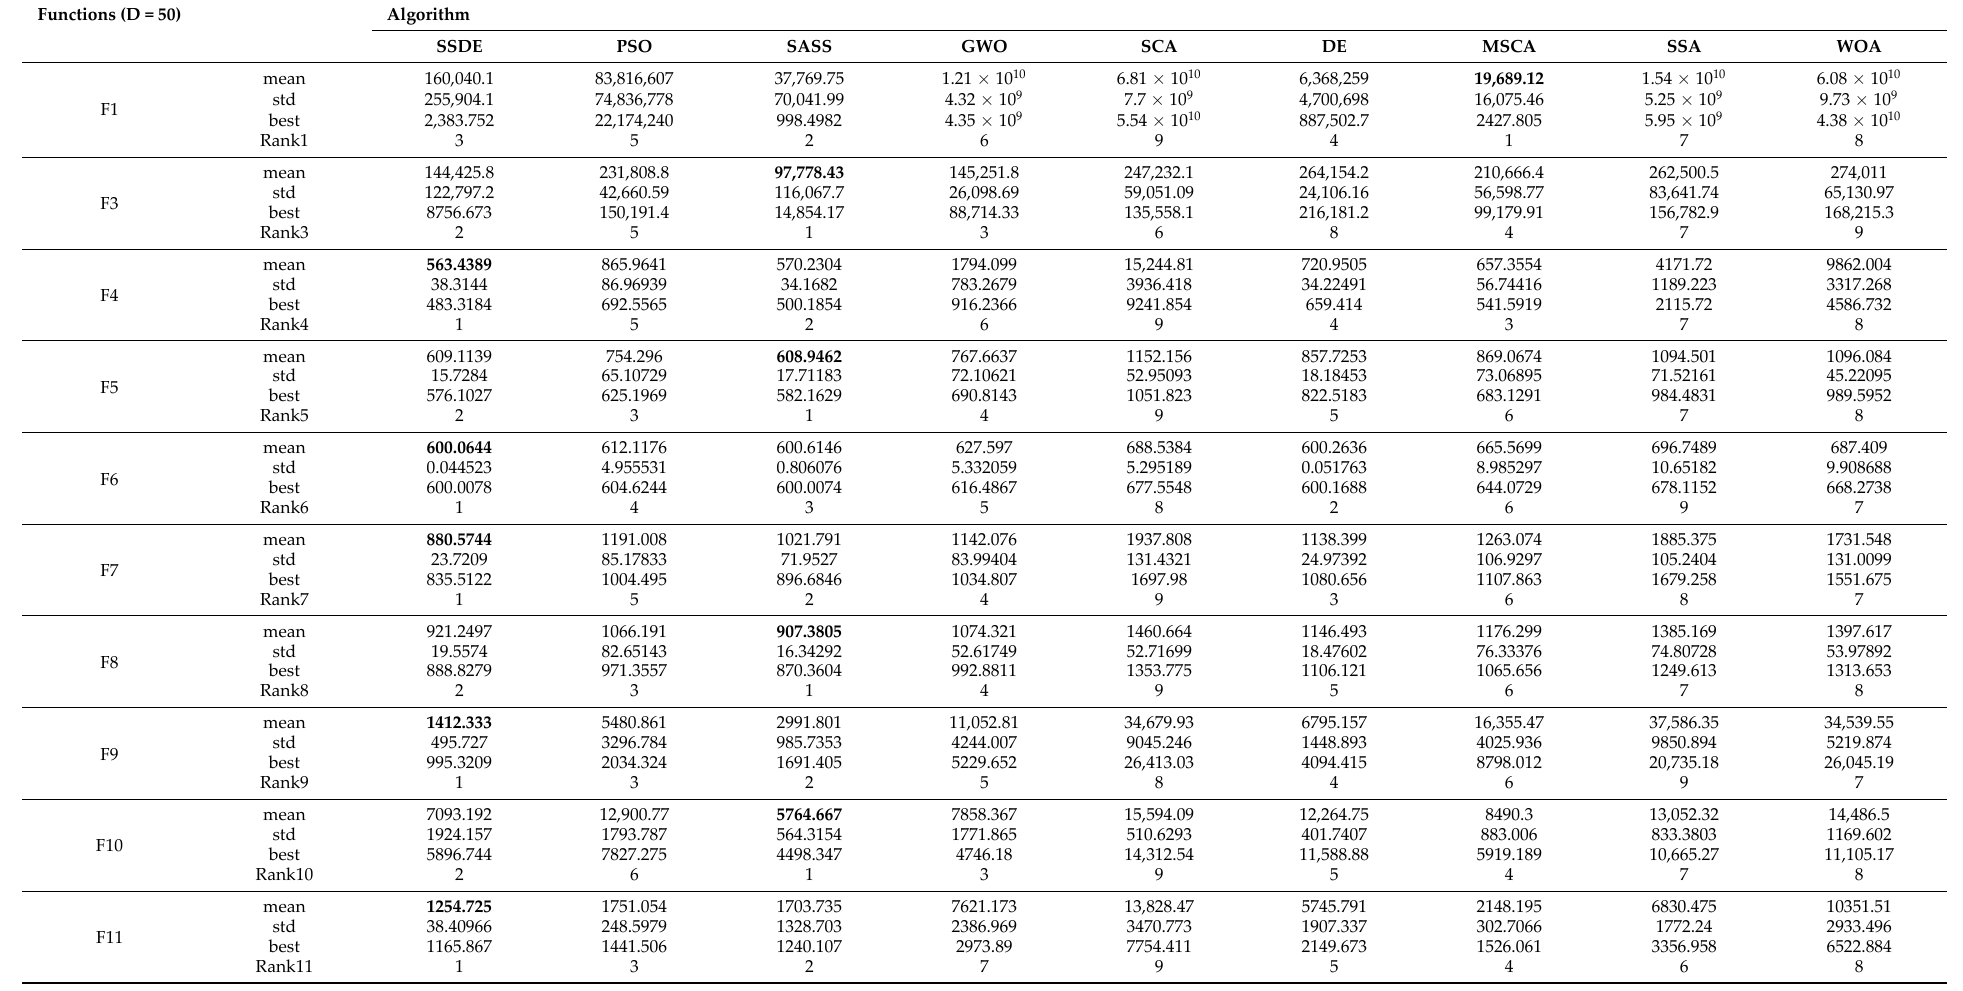
Table 5. Experimental results of IEEE CEC 2017 test problems with 50